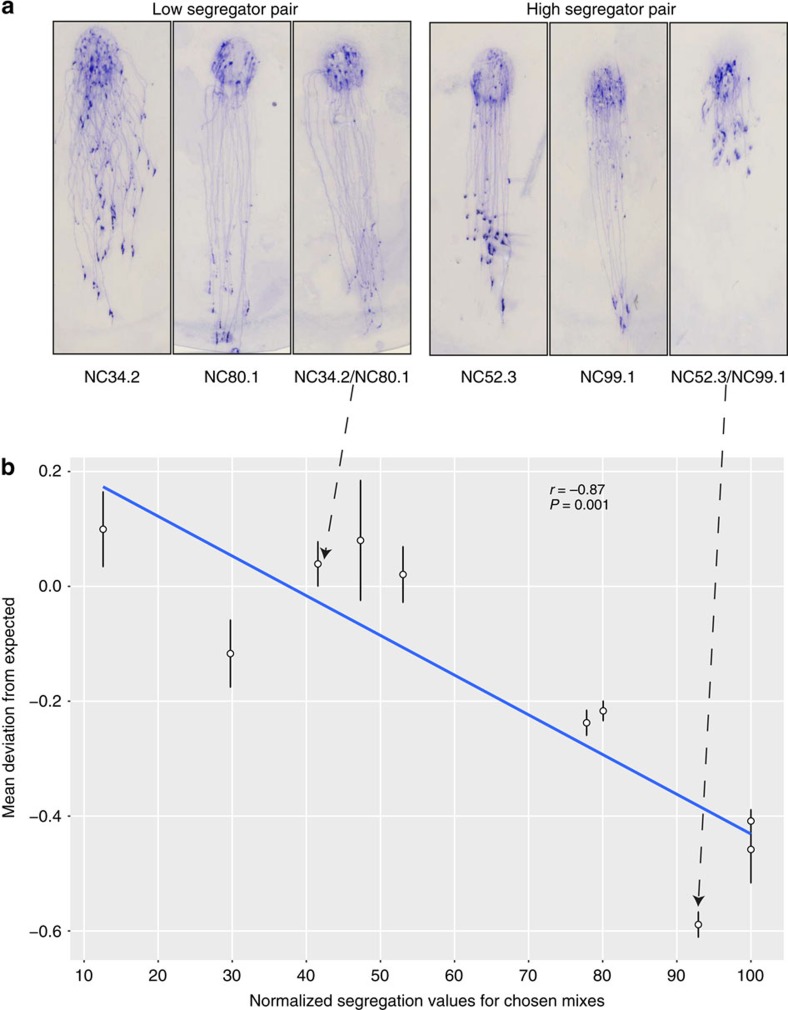
Strains with higher segregation values exhibit reduced slug migration.(a) Representative slug trail images from clonal and chimeric pairs showing low (41%) and high segregation (93%). The circular area at the top represents the spot where cells were initially plated and is the point of origin of the slug trails. Slugs were allowed to form and migrate toward a unilateral light source at the bottom of the dish over a period of 30 h before the trails were transferred from the surface of the agar onto a PVC disc and then stained with Coomassie Brilliant Blue. (b) Slug migration distances across ten different pairwise strain combinations. The mean migration distances were calculated for each clone and chimeric mix from four replicates (error bars depict s.e. of these four replicates). Expected chimeric values for each pair were then calculated as an average of the slug migration of each clone in the mix. Slug migration values are expressed as a deviation from these expected values. Mean slug migration distances of the high segregating pairs (>90%) are significantly shorter (Pearson's product moment correlation; r=0.87, P=0.001) than the expected migration distances based on the slug migration of the two respective clones in isolation.